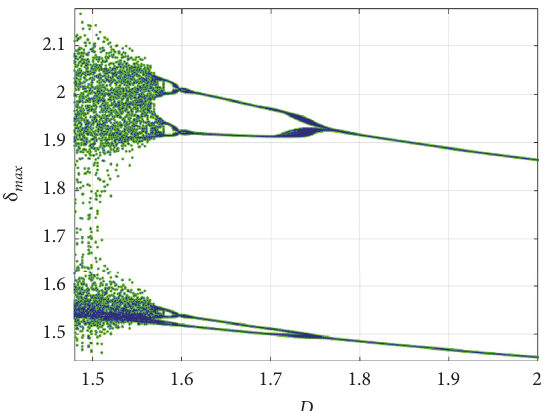
Figure 6: Bifurcation diagram for fractional-order power system (10), showing the local maxima for the state δ with respect to the parameter D .